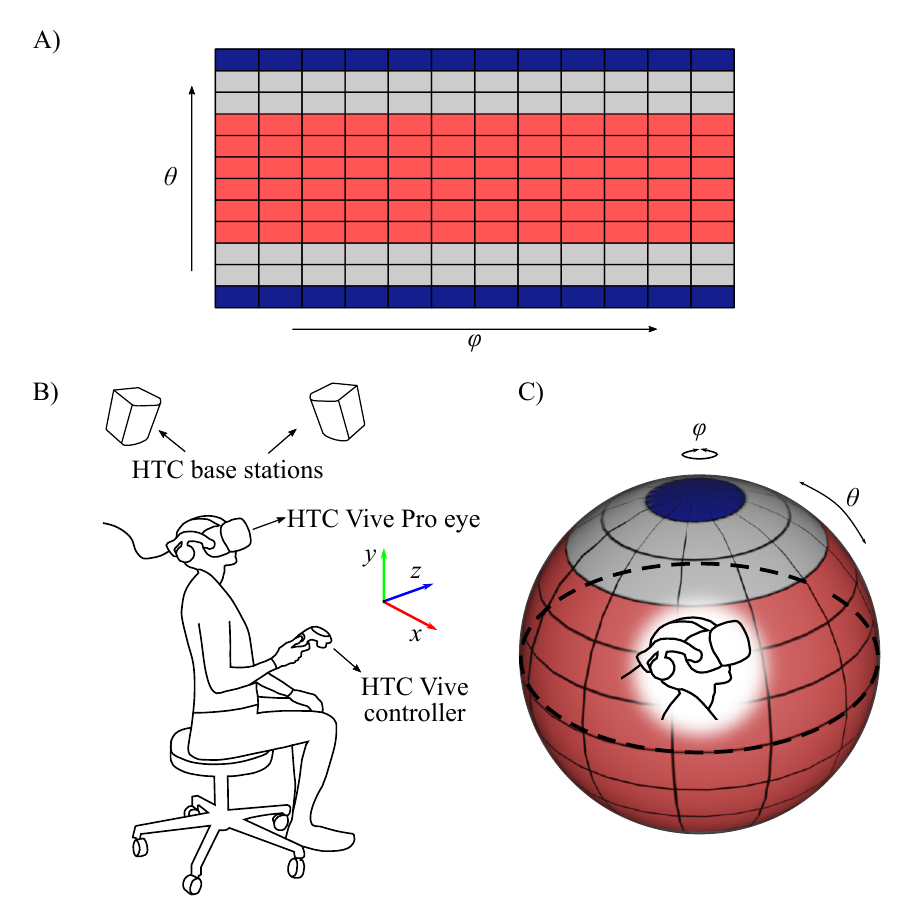
Figure 1. ( A ) A schematic representation of equirectangular projection. Each rectangle is 30° wide and 15° high. ( B ) The experimental setup. The experimental paradigm was implemented in Unity software and displayed in a VR headset—HTC Vive Pro Eye with a built-in eye tracker. Position and rotation tracking of the headset was realized via the HTC base stations 2.0. The participant performed the experiment in a seated position on a rotating stool. As soon as the search target was located, the participant pressed a button on the HTC Vive controller. Additionally, a left-hand coordinate system is shown, which is used to set the Unity world coordinates. For details on the experimental procedure see Section 2.4.1. ( C ) A schematic representation of a sphere to which the equirectangular projections (omnidirectional images) were back-projected in Unity as a Skybox. The colors indicate like-colored locations on the equirectangular projection in ( A